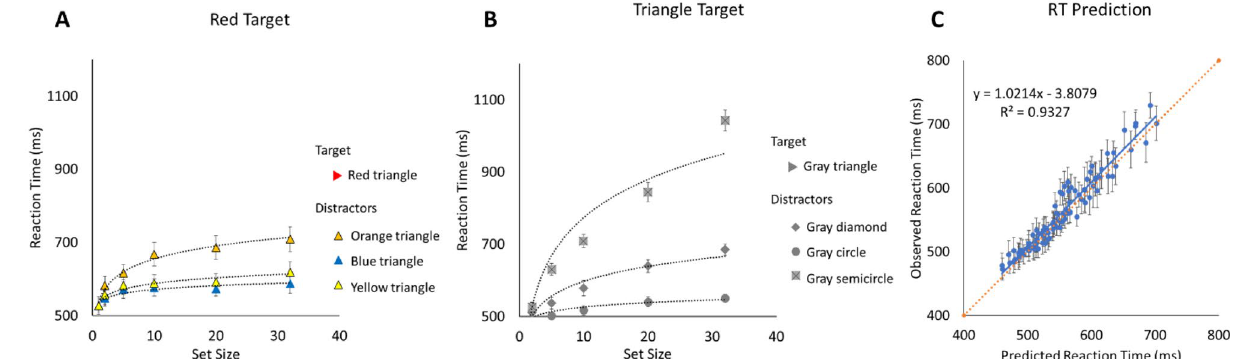
Figure 2. Results from Buetti et al. 4 . ( A ) Example of color search. The Figure shows reaction times when searching for a red triangle among a varying number of orange, yellow or blue triangles. Displays were always distractor homogeneous, meaning that only one distractor type was presented at a time. Results show that search efficiency, here indexed by the logarithmic search slope, varies as a function of target-distractor similarity. Search becomes less efficient when target-distractor similarity increases. ( B ) Example of shape search. The Figure shows reaction times when searching for a gray triangle among a varying number of gray diamonds, circles or semicircles. ( C ) Search efficiency observed in simple color and shape searches can be used to predict performance when the target differs from distractors both along color and shape. For instance, search efficiencies when searching for red among yellow ( A ) and when searching for triangle among diamonds ( B ) were used to predict performance when participants searched for a red triangle target among yellow diamonds. The Figure shows the predictions from the best performing model (Collinear Contrast Integration model, as is shown in Eq. (3)). Error bars on each data point indicate the standard error of the observed reaction time for each specific of contrast accumulation is influenced by a number of factors, such as eccentricity, but more important here, target-distractor dissimilarity. So, when the visual distinctiveness between the target and distractor is large (e.g., searching for a red target among blue items), the contrast signal will accumulate at a faster rate, resulting in shallower logarithmic slopes, that is, in faster search efficiency (blue triangle line, Fig. 2A). When the visual distinctiveness between the target and distractors is small (e.g., searching for a red target among orange items), the contrast will accumulate at a slower rate, resulting in steeper logarithmic slopes and in slower search effi- ciency (orange triangle line, Fig. 2A). Thus, Target Contrast Signal theory proposed that the steepness of the logarithmic slope is inversely proportional to the overall contrast signal being accumulated between a given target-distractor pairing, such that